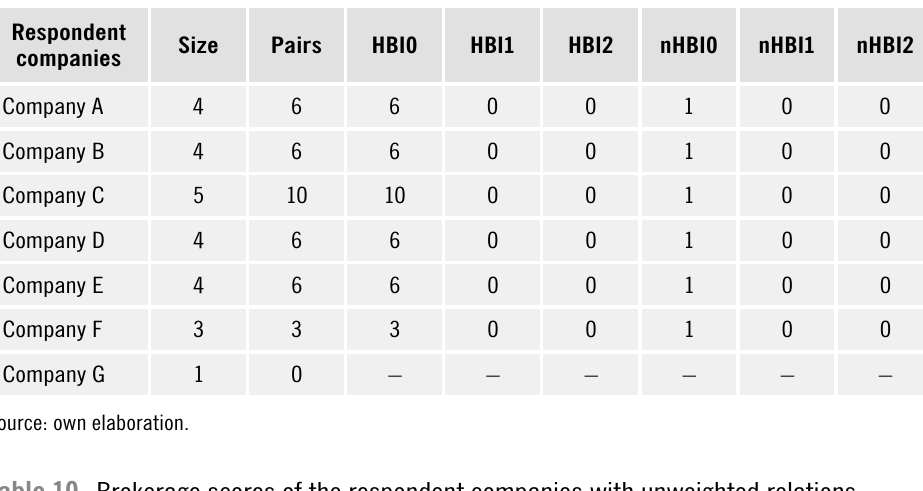
Table 10. Brokerage scores of the respondent companies with unweighted relations